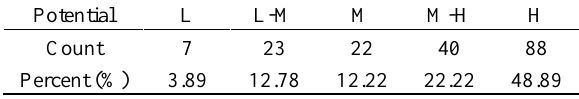
Table 7. Count of wind farm in each potential